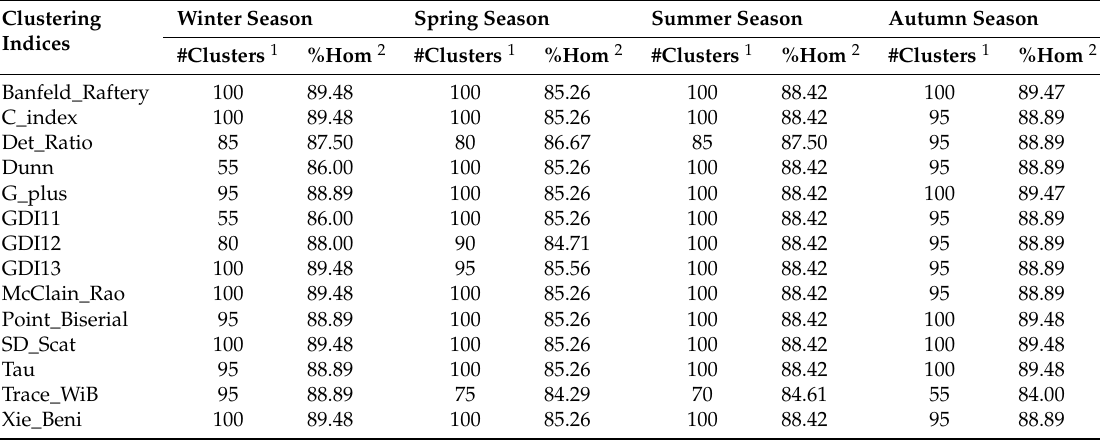
1 # Clusters: Number of Clusters; 2 % Hom: Percentage